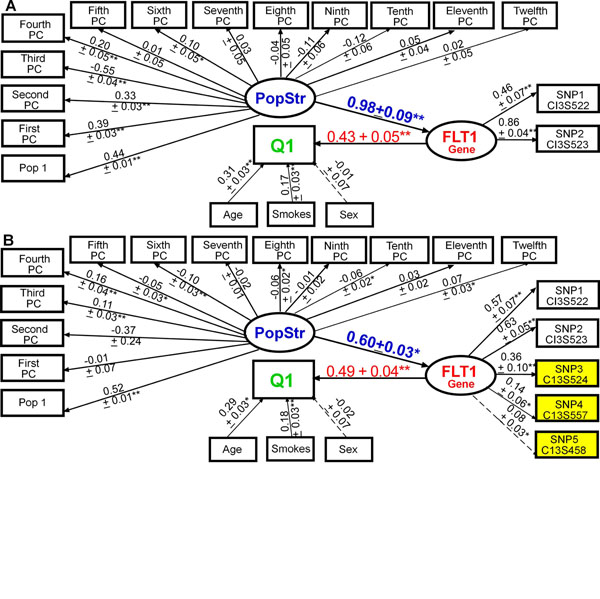
Modeling the aggregate effects of common and rare variants in FLT1 using latent variable structural equation modeling. Adding rare variants (B) to the FLT1 latent construct composed of common variants (A) improved the model fit (A: CFI = 0.90, RMSEA = 0.03, SRMR = 0.08; vs. B: CFI = 0.96, RMSEA = 0.02, SRMR = 0.05) and the variance explained in Q1 (R2: 0.36 ± 0.04 (B) vs. 0.30 ± 0.04 (A)). Standardized parameters and standard errors are shown above the arrows. Yellow, rare variant; blue, population substructure (PopStr; principal component, PC); red, gene; green, trait. * p ≤ 0.05; ** p ≤ 0.001. Residuals not shown for clarity.